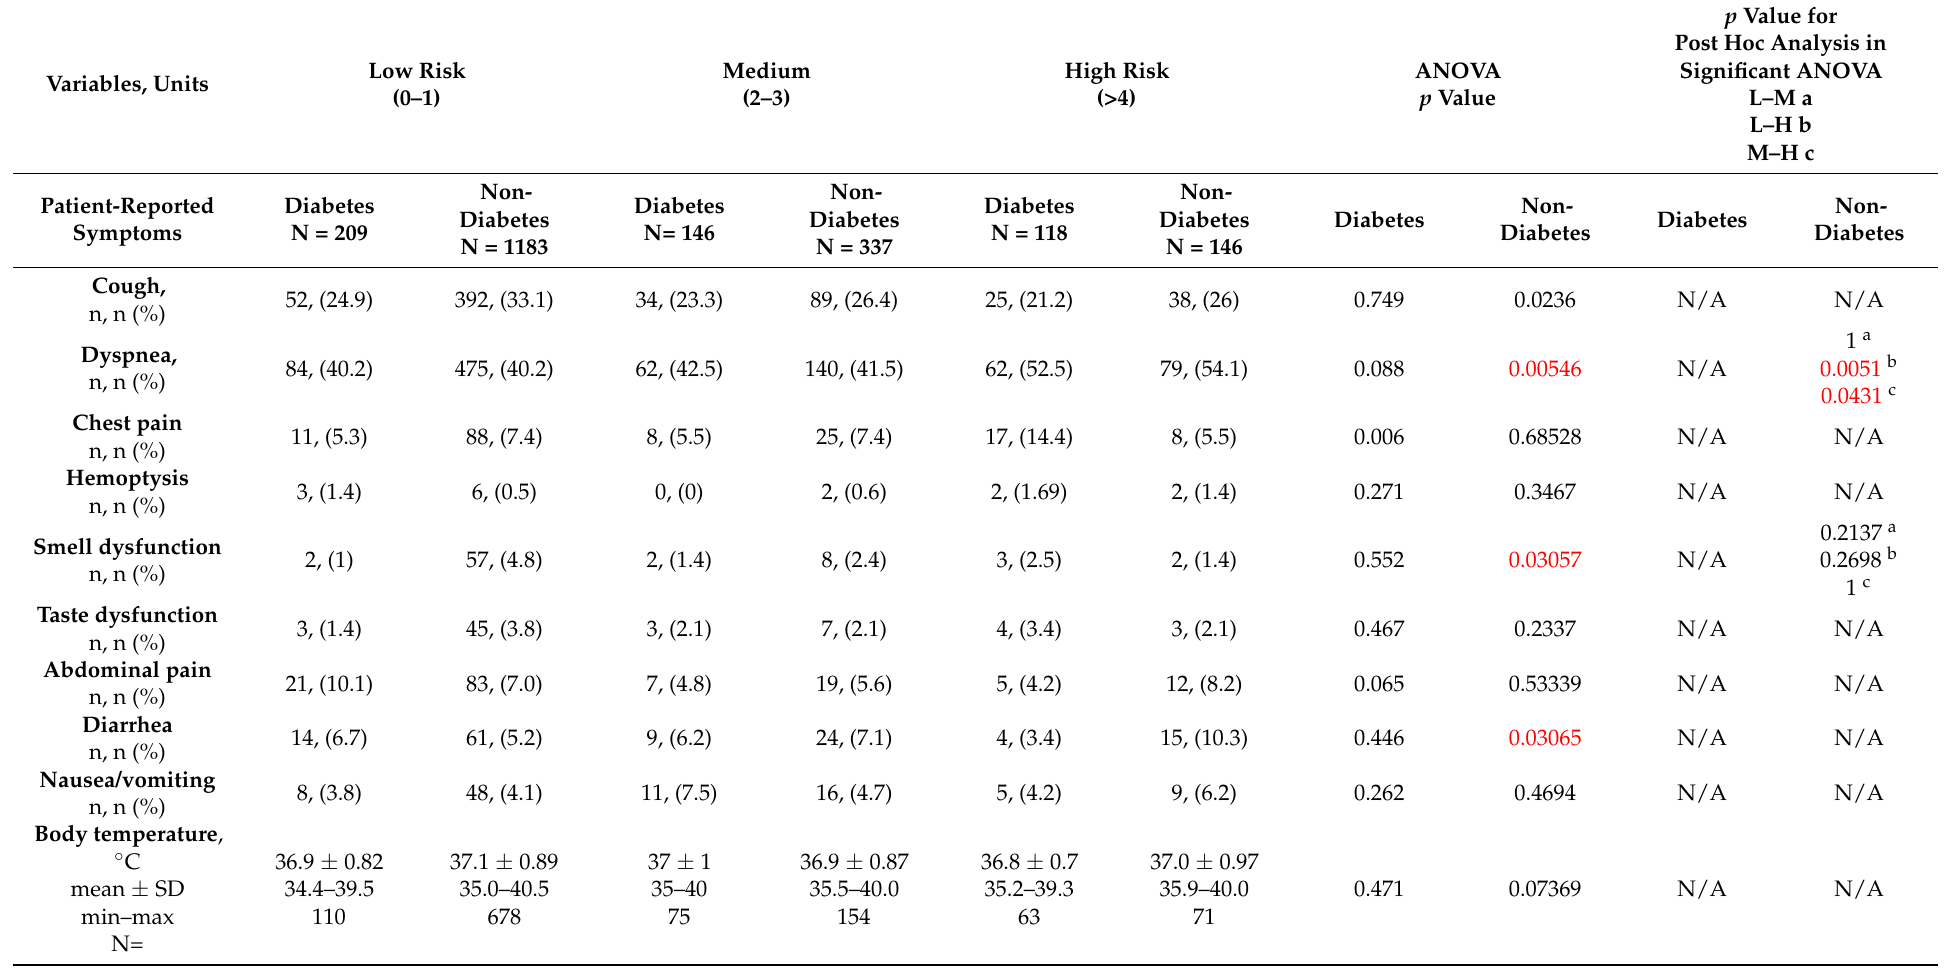
Table 2. Patient-reported symptoms, vital signs, and abnormalities measured during physical examination at hospital admission in the diabetic and non-diabetic